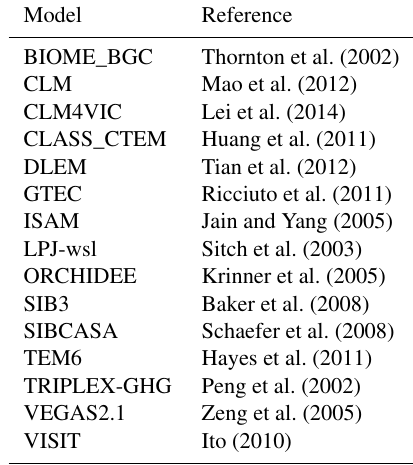
Table 1. Global terrestrial biosphere models from the Multi-scale Synthesis and Terrestrial Model Intercomparison Project (MsTMIP) downscaled in this